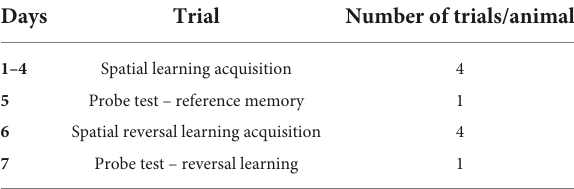
TABLE 1 Design set-up of the Morris Water Maze (MWM) test.